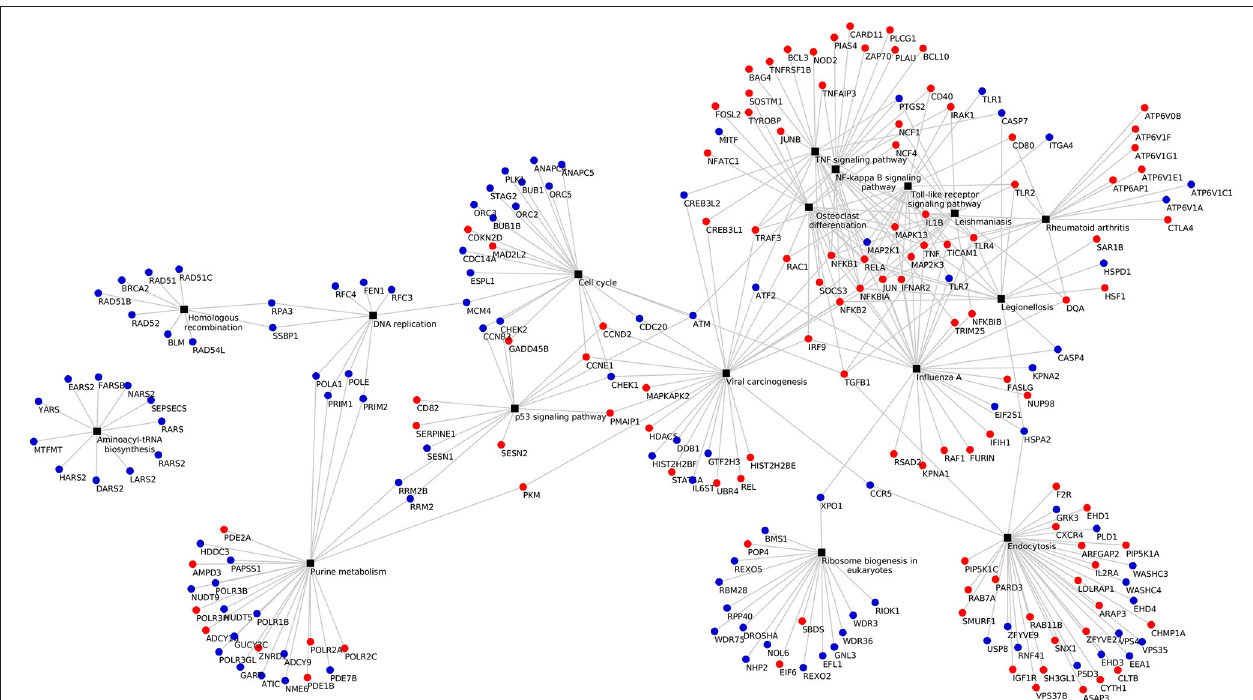
FIGURE 5 | Enriched KEGG pathways in the Vac Tf vs. Vac T0 comparison in DAVID with EASE Score (a modified Fisher’s exact test) and Benjamini-Hochberg False Discovery Rate correction. Black boxes represent different pathways and the points the differentially expressed genes in each pathway, up-regulated ones in red and down-regulated ones in